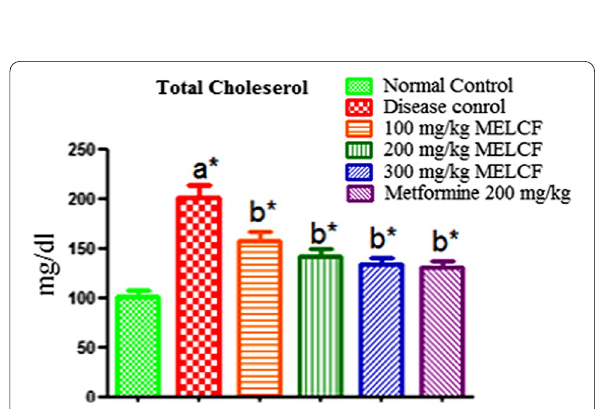
Fig. 6 Effect of MELCF on total cholesterol. The values represented as mean SEM ( n 6). a* ( p < 0.05) when compared to normal control ± = and b* ( p < 0.05) when compared to disease/diabetic control